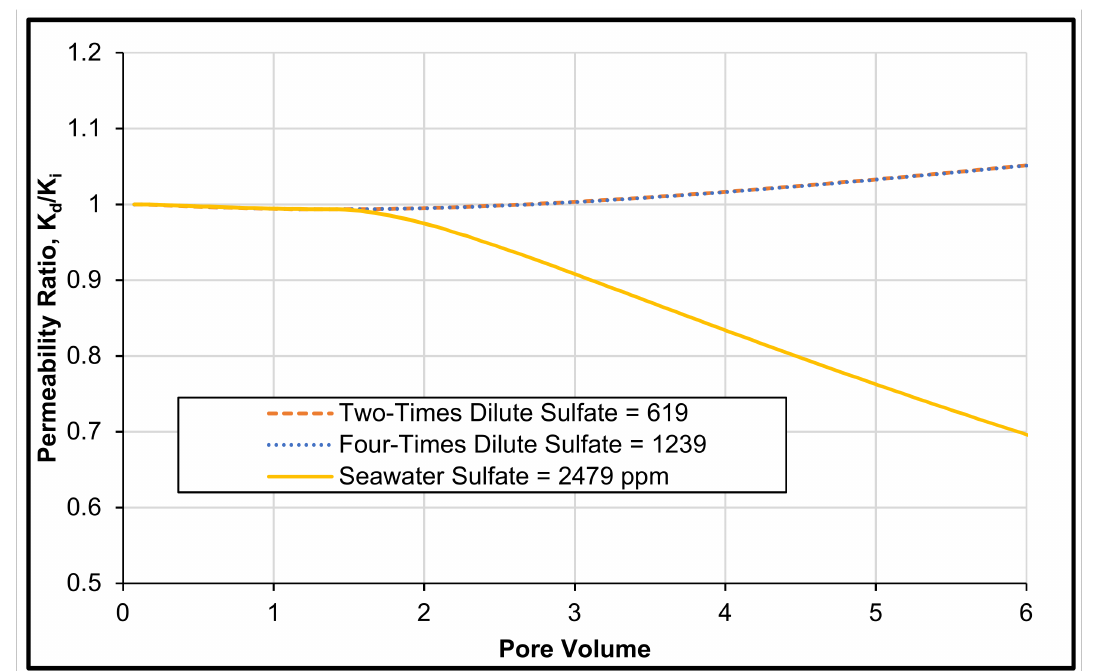
Figure 8. Effect of sulfate concentration on formation permeability ratio for the first gridblock at 6 PVs with formation and injected water temperatures fixed at 200 ◦ C and 100 ◦ C,